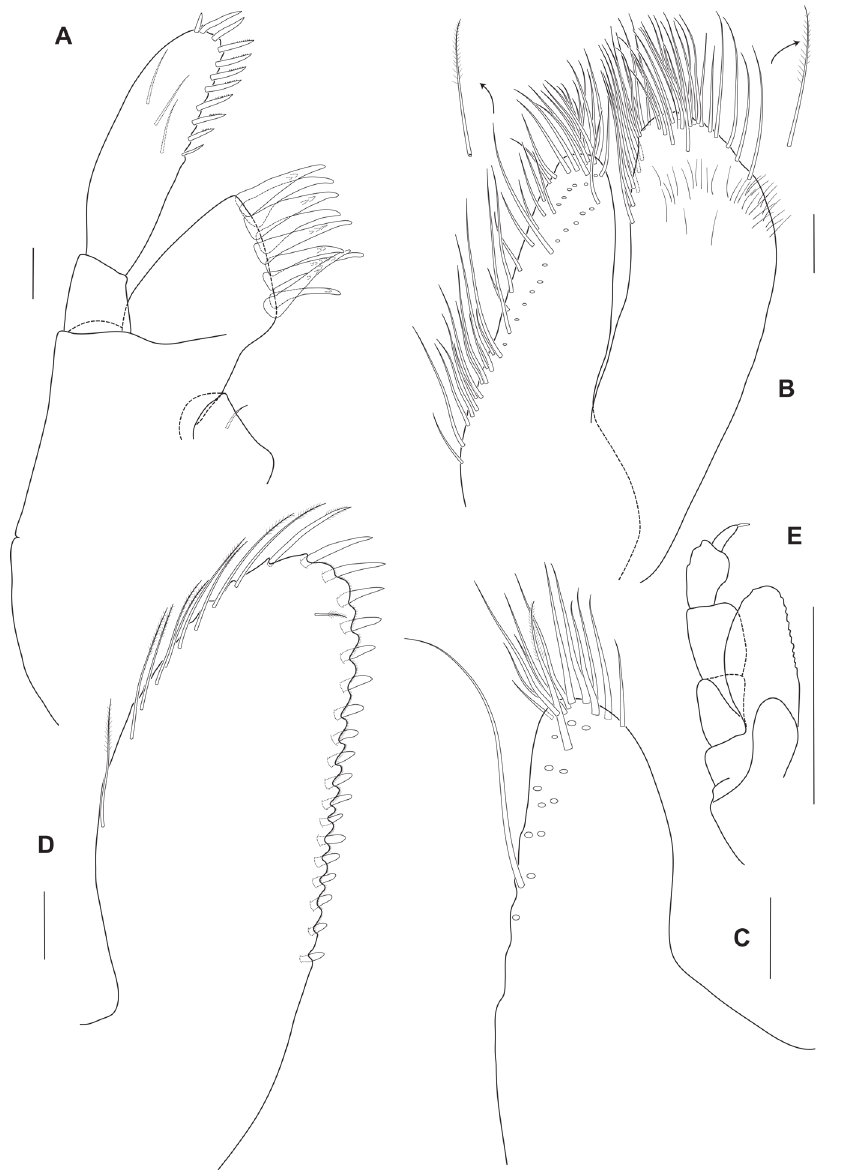
Figure 5. Ampithoe tarasovi Bulycheva, male holotype A maxilla 1 B maxilla 2 C inner lobe of maxilliped D outer lobe of maxilliped E maxilliped. Scale bars: 0.1 mm ( A–D ); 1 mm ( E ). rounded defining tooth on posterodistal corner; dactylus slightly overreaching palm, curved, robust, apically blunt, without